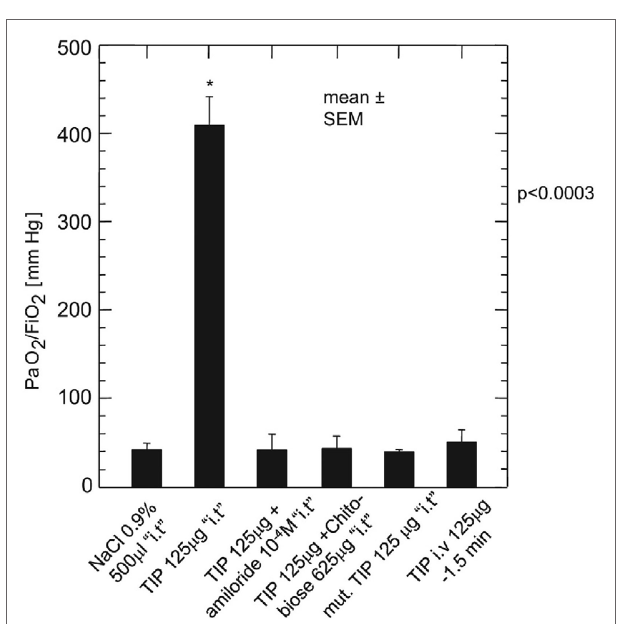
FigURe 11 | Oxygenation at 24 h after transplantation. At sacrifice, 24 h after reperfusion of the left-sided lung transplant, the PaO2/FIO2 ratio was measured after excluding the native right-sided lung by clipping the right-sided stem bronchus and right-sided pulmonary artery. The animals were tracheotomized and ventilated with an FIO2 of 1.0. The tumor necrosis factor tip peptide significantly increased gas exchange compared with all other study groups. * p < 0.003 versus NaCl. Data are mean ± SEM. i.t., intratracheally (8).